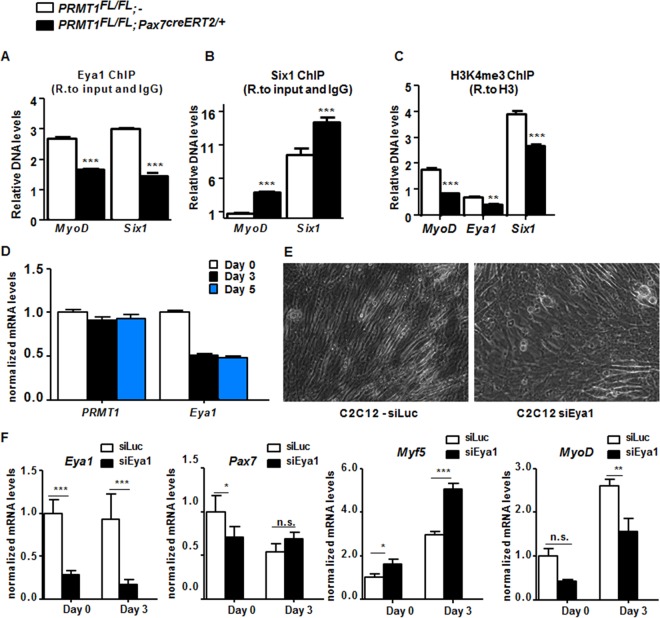
PRMT1 controls MyoD expression via mediation of Eya1/Six1 activity. (A) Relative (R.) levels of DNA from ChIP of Eya1 at MyoD, Eya1, and Six1 upstream promoter region (approximately bp −500) normalized to input and IgG. (B) Relative levels of DNA from ChIP of Six1 at MyoD, Eya1, and Six1 upstream promoter region (approximately bp −500) normalized to input and IgG. (C) Relative levels of DNA from ChIP of the histone mark H3K4me3 at MyoD, Eya1, and Six1 upstream promoter region (approximately bp −500) normalized to H3. (D) C2C12 cell were differentiated for days 0, 3, and 5, and the mRNA levels of PRMT1 and Eya1 were measured by RT-qPCR and normalized to the average of GAPDH, R18S, and TBP. (E) A representative differential interference contrast image of C2C12 cultures after transfection with siLuciferase (siLuc) or siEya1 under differentiation conditions. (F) mRNA levels of Eya1, Pax7, Myf5, and MyoD were measured by RT-qPCR and normalized to GAPDH, R18S, and TBP in C2C12 transfected with siLuc or siEya1, harvested as undifferentiated (day 0) or after 3 days of culture in differentiation medium (day 3). *, P < 0.05; **, P < 0.01; ***, P < 0.001; n.s., not significant.